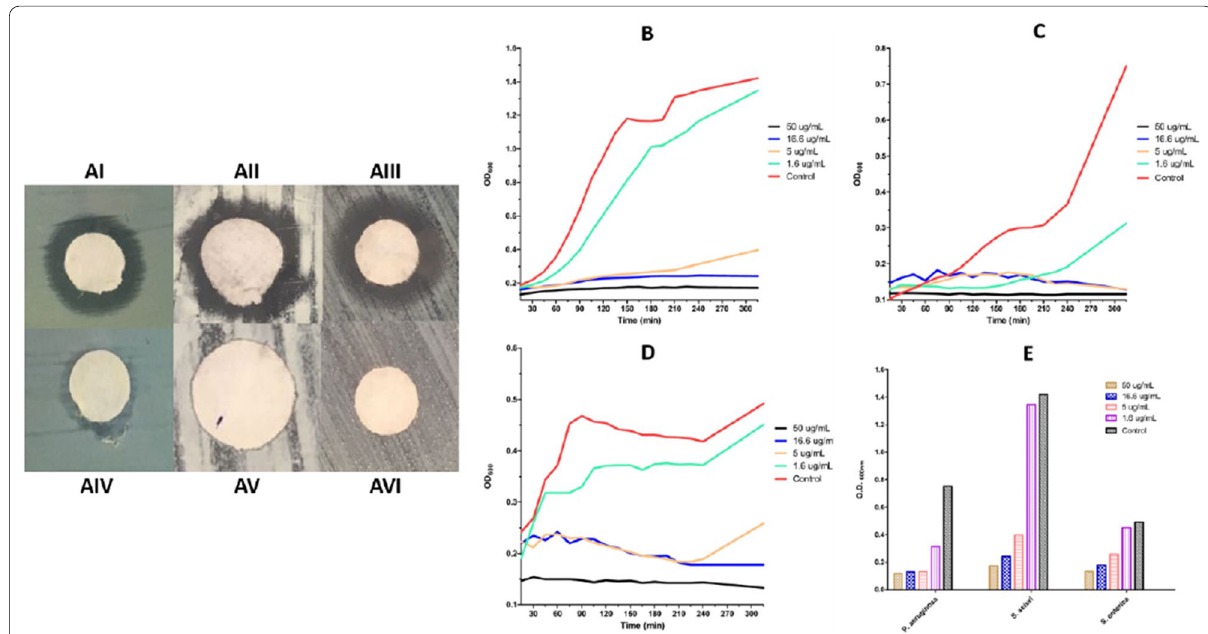
Fig. 6 The antibacterial activity of Ag‑AuNPs against the bacteria A by disc diffusion method against AI P. aeruginosa AII S. sciuri AIII S. enterica using Ag‑AuNPs and the negative control for the same bacteria ( AIV , AV , and AVI ) respectively. Moreover, the time‑killing curve during 315 min of B S. sciuri C P. aeruginosa D S. enterica after being treated with different concentrations of Ag‑AuNPs. The chart E represents the readings at OD 600 after 315